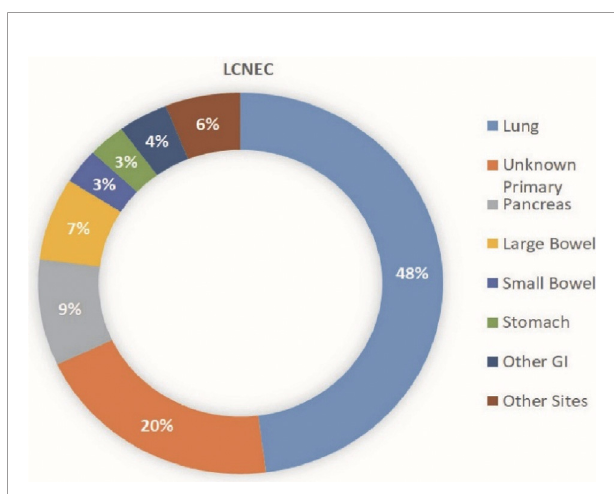
FIGURE 2 | Distribution of LCNEC based on site of origin. This graphic shows the distribution of large cell neuroendocrine primary tumor